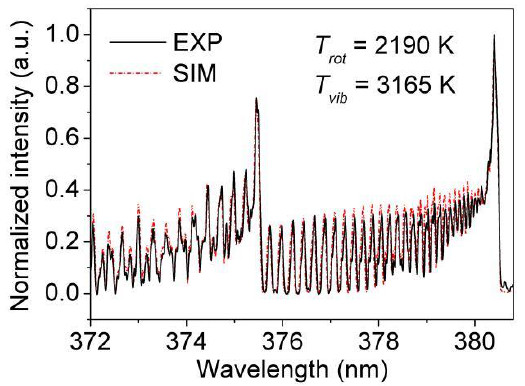
Figure 5. Experiment and simulation N 2 (C 3 ∏ u ) temperature (applied voltage: 5.6 kV, Ar flow rate: 1.68 L/min, pH = 3.59, 2% (V/V) ethanol). 1.68 L/min, pH = 3.59, 2% (V/V)